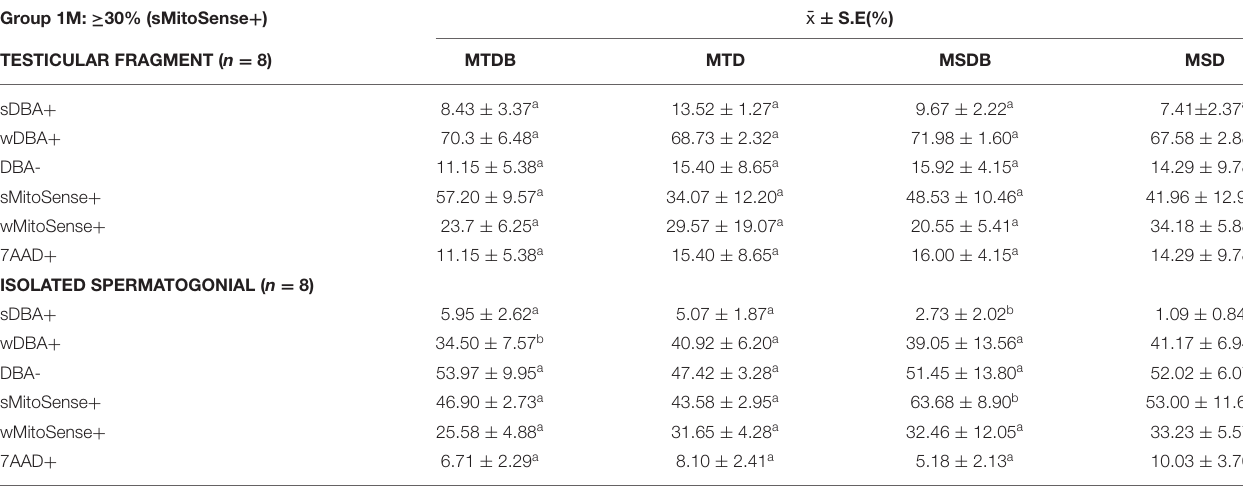
TABLE 3 | Mean percentage of spermatogonial stem cell with intact mitochondrial activity (sMitoSense + ), early apoptosis (wMitoSense) and necrosis (7AAD + ) in-group 1M. Group 1M: ≥ 30% (sMitoSense + )